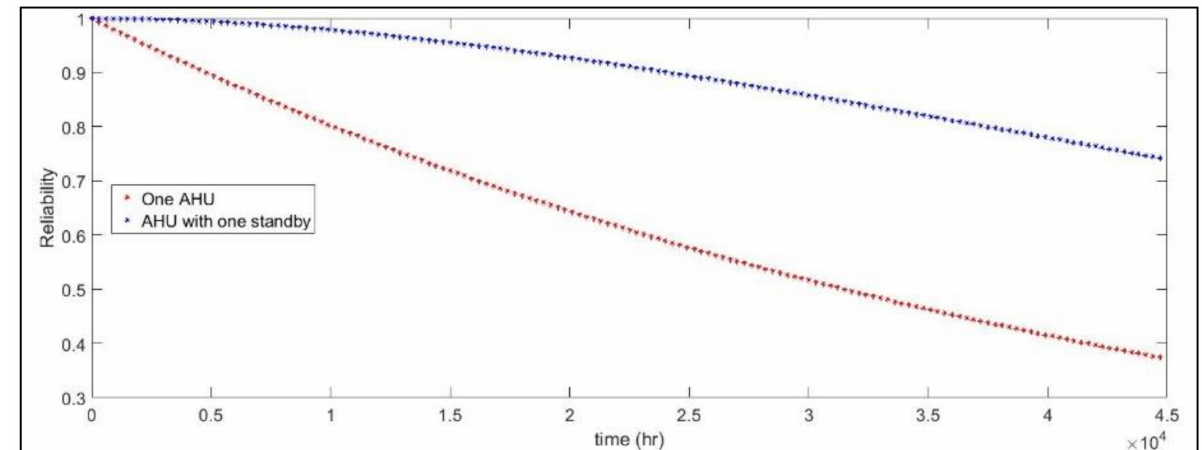
Figure 5. Comparing the reliability of a stand-alone AHU vs. two